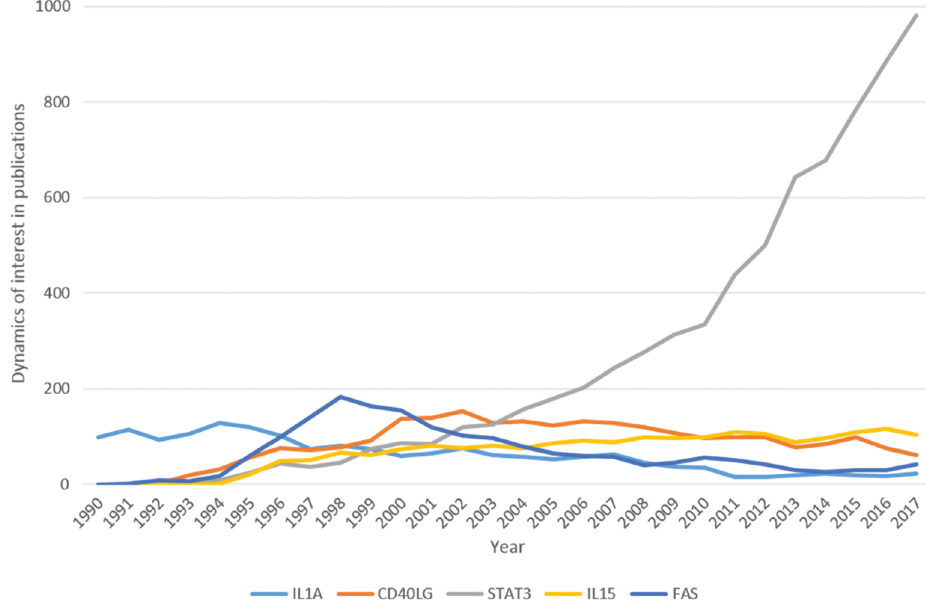
Figure 2: The dynamics of researcher ’ s interest for the top 5 most priority genes, according to scientific publications of